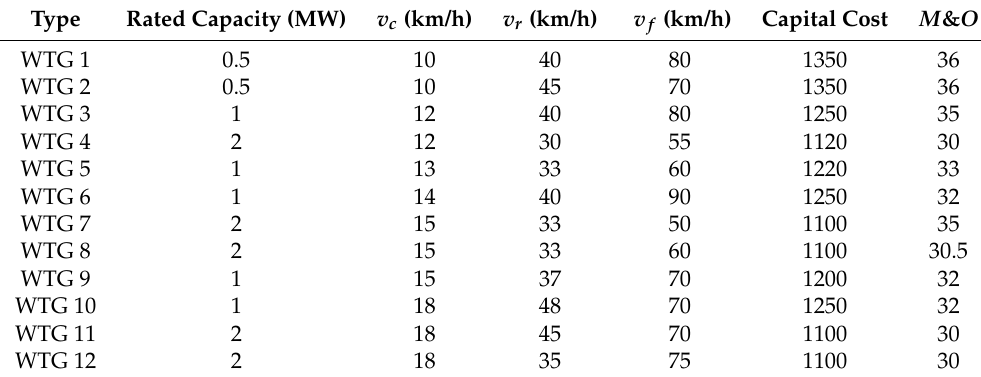
Table 1. WTG Unit